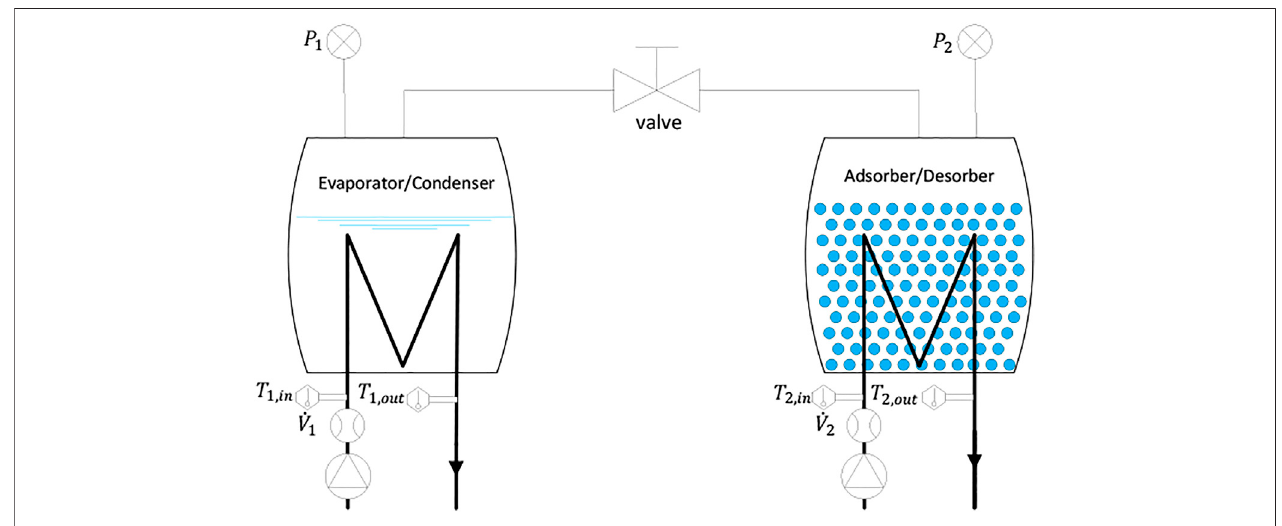
FIGURE 2 | Schematic drawing of the test setup.